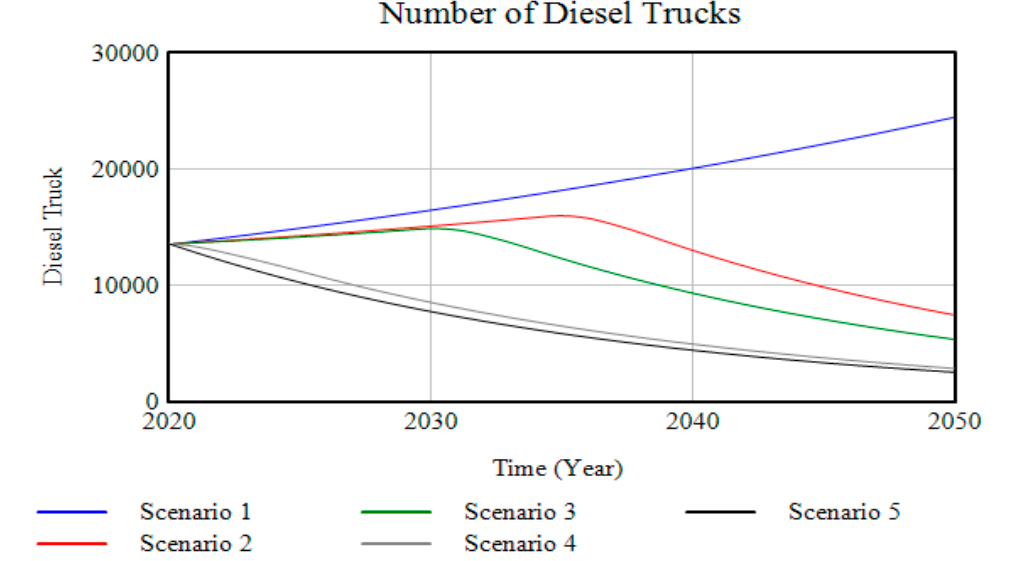
Figure 4. Number of diesel trucks.